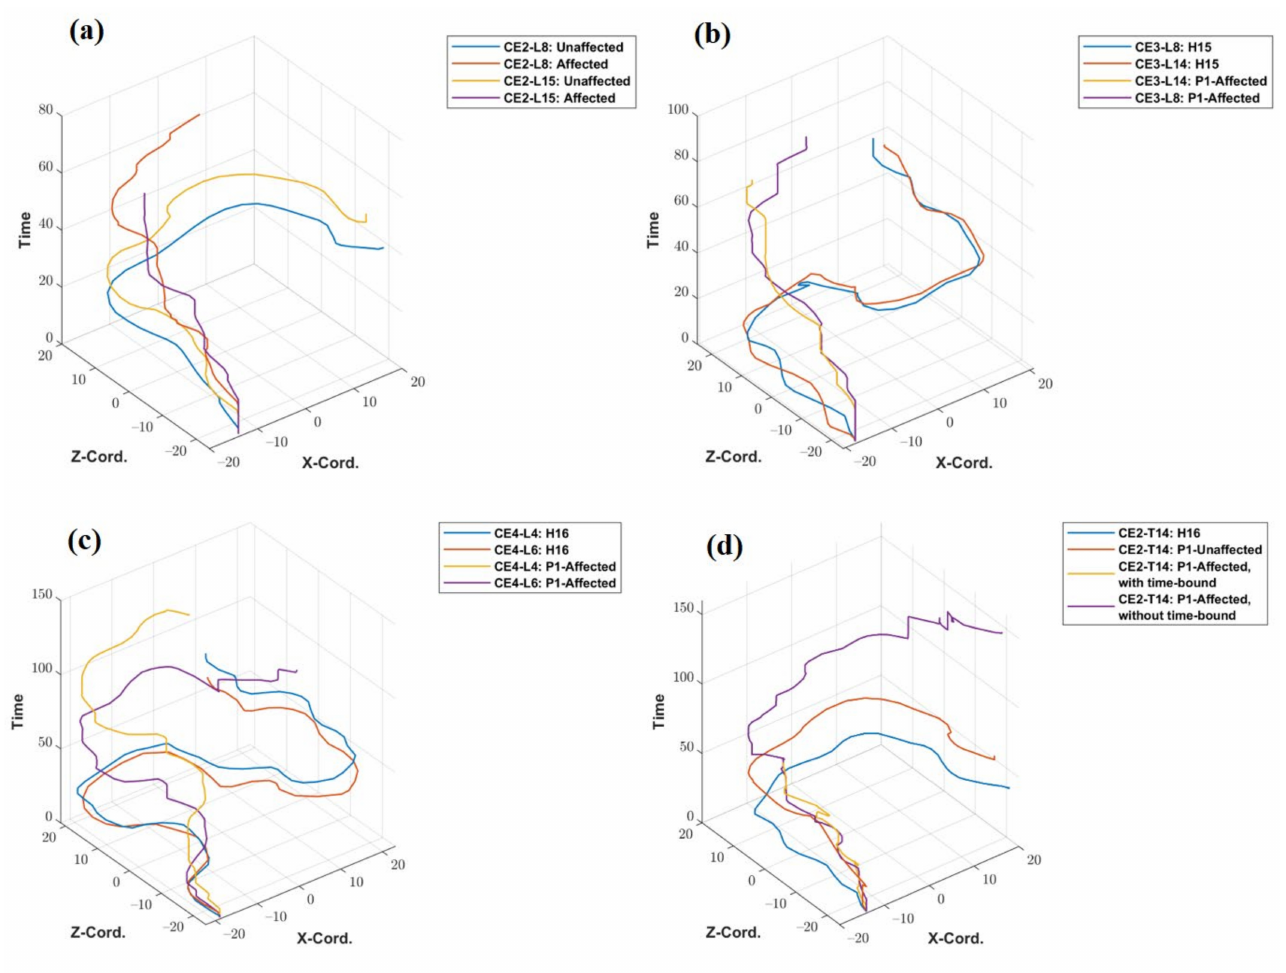
Figure 7. Trajectory plotted ( a ) for P1’s unaffected and affected hands for task levels CE2-L8 and L15, ( b ) for a healthy subject and P1’s affected hand for task levels CE3-L8 and L14, ( c ) for a healthy person and P1’s affected hand for task levels CE4-L4, and L6, ( d ) for a healthy subject and P1’s affected hand, with and without the time-bound conditions for task level